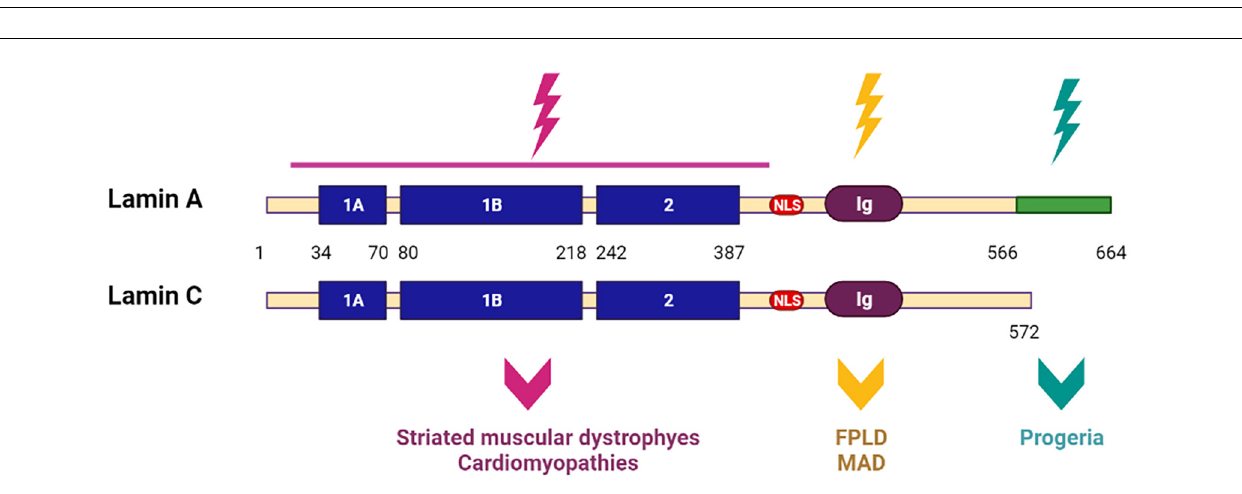
FIGURE 8 | Phenotypic spectrum of laminopathies and the different tissues affected. Created with BioRender.com.